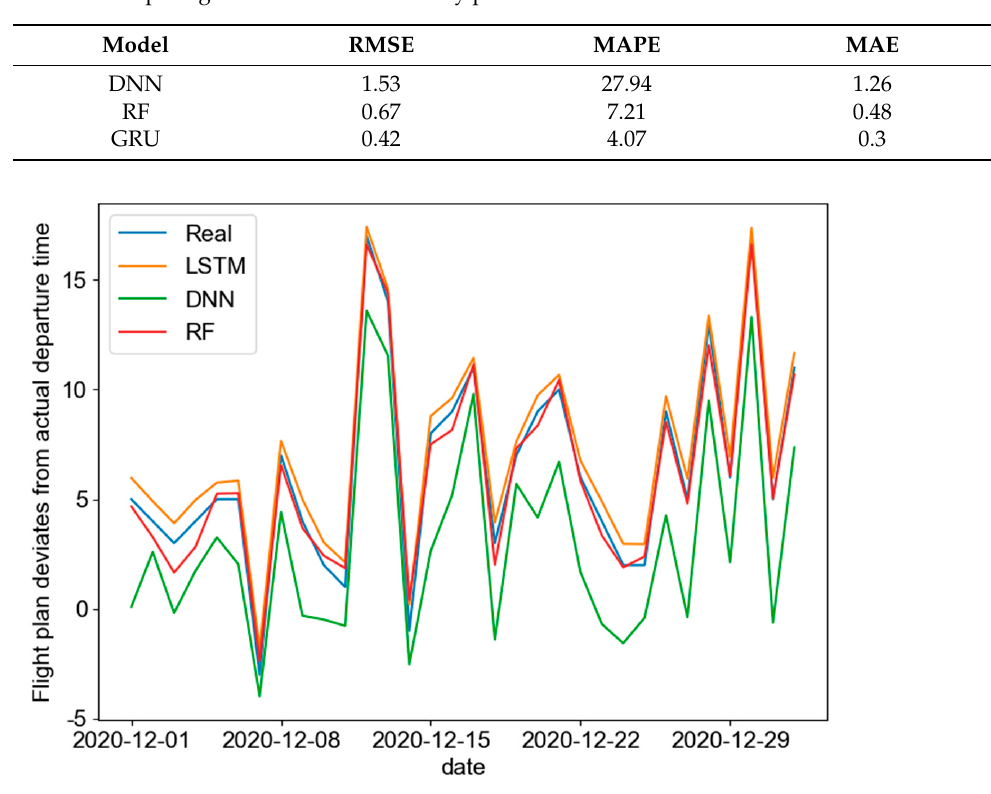
Figure 9. Three kinds of model fitting effect graph.